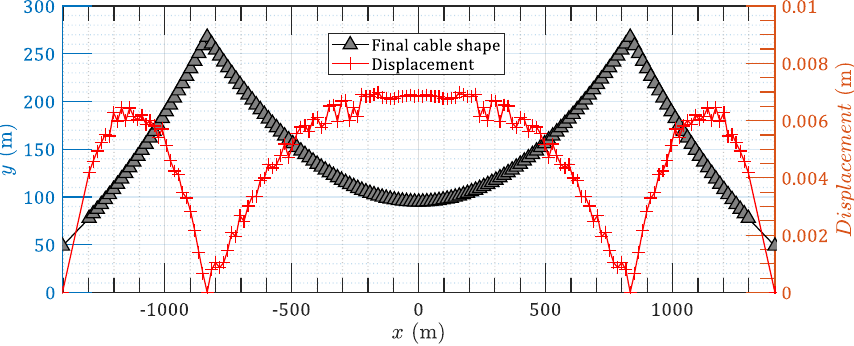
Figure 9. Static displacement of the final 2D parallel main cable achieved by the FEM. Three dimensional spatial main cables are applied to the same suspension bridge